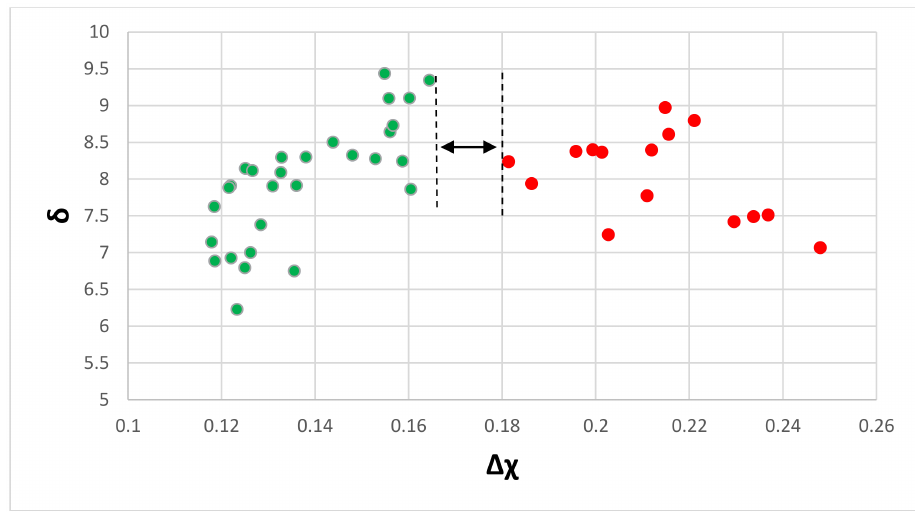
Figure 4. δ versus ∆ χ of eutectics with Nb ss and Nb 5 Si 3 in Nb-silicide based alloys. The gap in ∆ χ values (0.164 < ∆ χ < 0.181) separates eutectics with low Ti concentrations (8.3 < Ti < 13.5 at.%), which are shown with filled red circles, from those of high Ti concentration (20.5 < Ti < 45 at.%), which are shown with filled green circles.